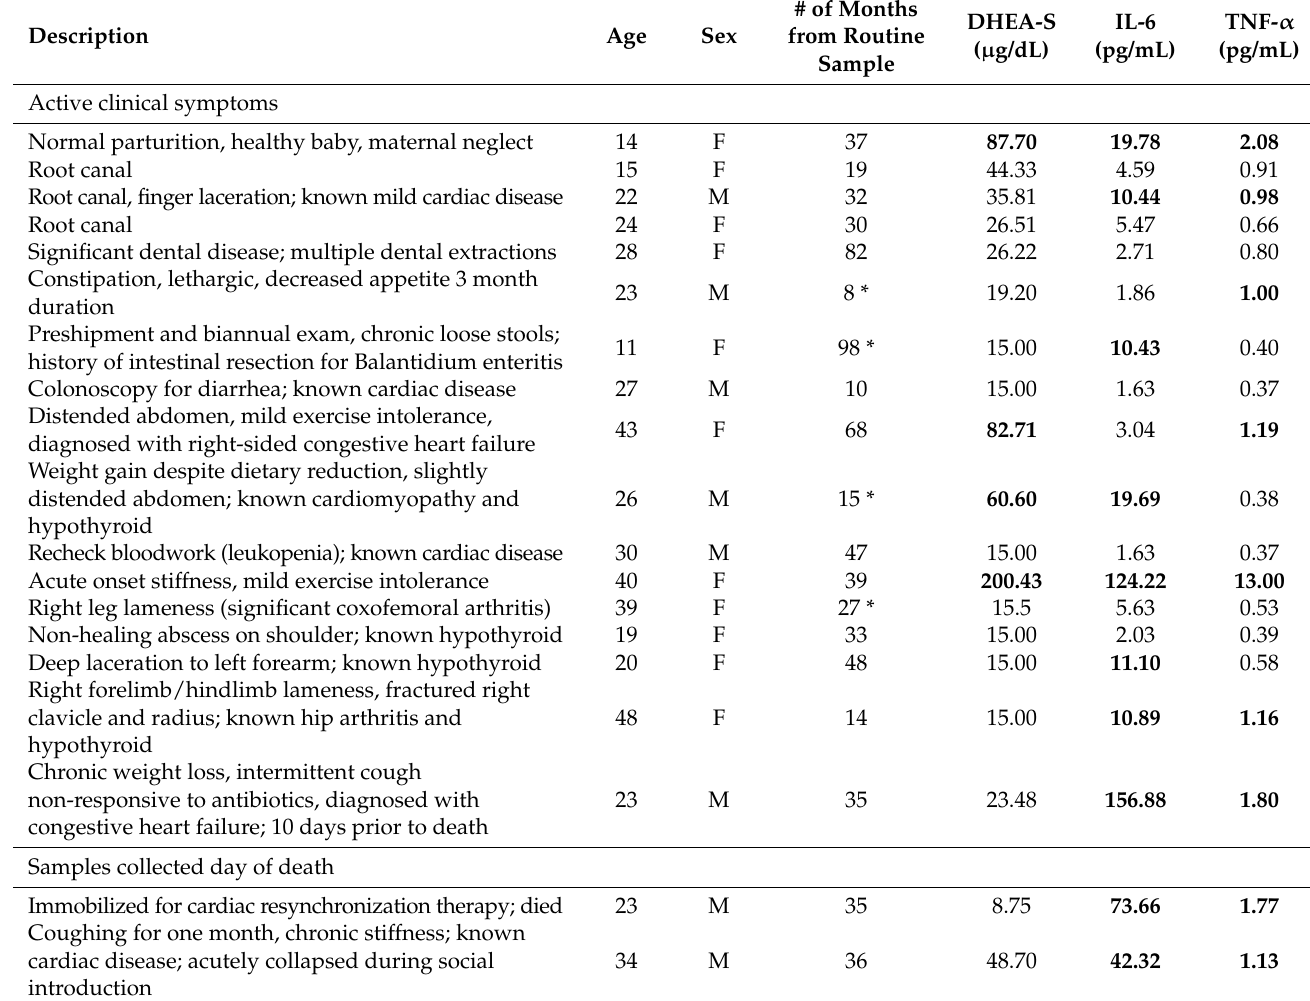
Table 2. DHEA-S, IL-6, and TNF- α concentrations in western lowland gorillas with active clinical symptoms or prior to death. Numbers in bold exceed the upper end of the calculated value range based on all gorillas